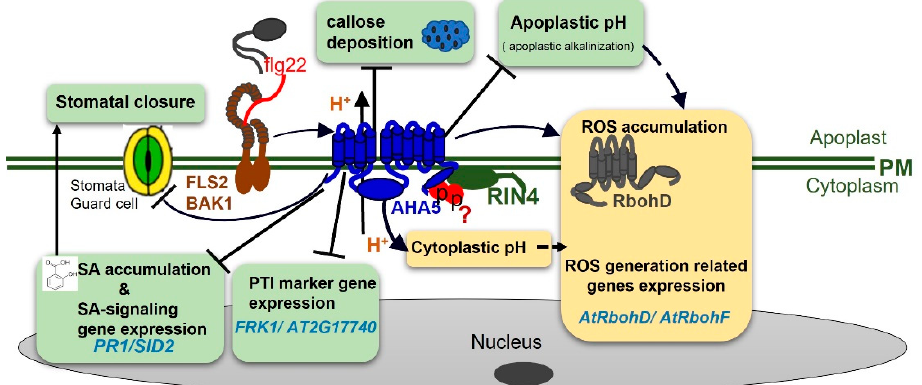
Figure 8. The hypothetical working model of the function of AHA5 involved in plant PTI upon the bacterial Pto infection. During the interactions, the bacterial pathogens, such as Pto bacteria strains, invade plants via stomata and release PAMPs. The perception of PAMPs (for example, flg22 in red) by plant PRRs (for example, FLS2-BAK1 complex) leads to the activation of the downstream defense components, including RbohD and AHA5. RbohD is responsible for converting O 2 to O 2 − to further form H 2 O 2 . AHA5 (associated with RIN4) could pump H + out of cytosol to the apoplast, leading to apoplastic acidification. Therefore, the mutation of AHA5 contributes to the apoplastic alkalinization. Moreover, AHA5 is positively involved in the production of H 2 O 2 and ROS synthesis-related gene expression ( AtRbohD and AtRbohF ) during PTI. Although the aha5 mutants exhibited lower levels of H 2 O 2 and ROS-related gene expression, the mutant plants still conferred the enhanced resistance against the Pto infection. The reason is that AHA5 is negatively involved in stomatal closure, callose deposition (blue clot with dots), SA accumulation, SA-signaling-related gene expression ( PR1 / SID2 ), and the other PTI-related gene expression ( FRK1 and AT2G17740 ). All these are critical plant PTI responses upon the pathogen infection. In addition, AHA5 interacts with RIN4, and they possibly function together in plant PTI. The AHA5–RIN4 interaction might be associated with the protein phosphorylation of RIN4 (red circle), which needs to be investigated in the future. Furthermore, AHA5 may also crosstalk with the other plant defense components to contribute to PTI, which also needs to be further investigated. Solid arrows show the mechanisms and pathways currently known in this study. Question marks and dotted arrows indicate the unknown or hypothetical mechanisms and pathways.